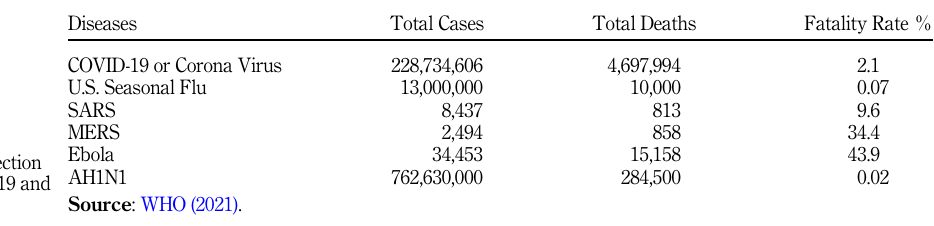
rates of COVID-19 and other